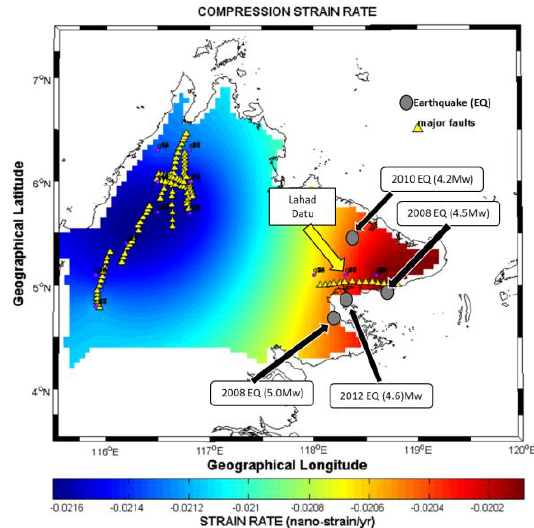
Figure 19. Strain rate (Compression) map contour over Sabah (2004-2013).